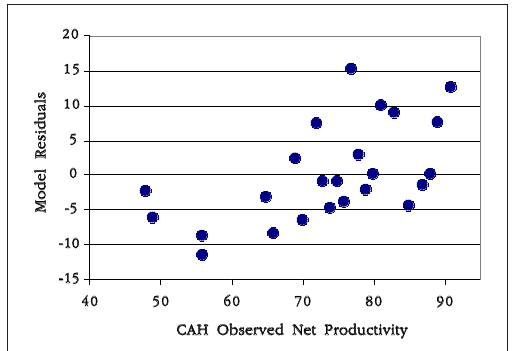
Fig. 3. Residuals (observed minus predicted values) of the final model selected by full stepwise procedures using a NAM Winter Index, Early Fall Snow from the previous year, and first day of zero snow depth in spring to predict net productivity (# calves:100 cows) observed during aerial surveys ~1 week after the peak of calving within the calving grounds of the Central Arctic Herd of Alaska, 1977–2002.